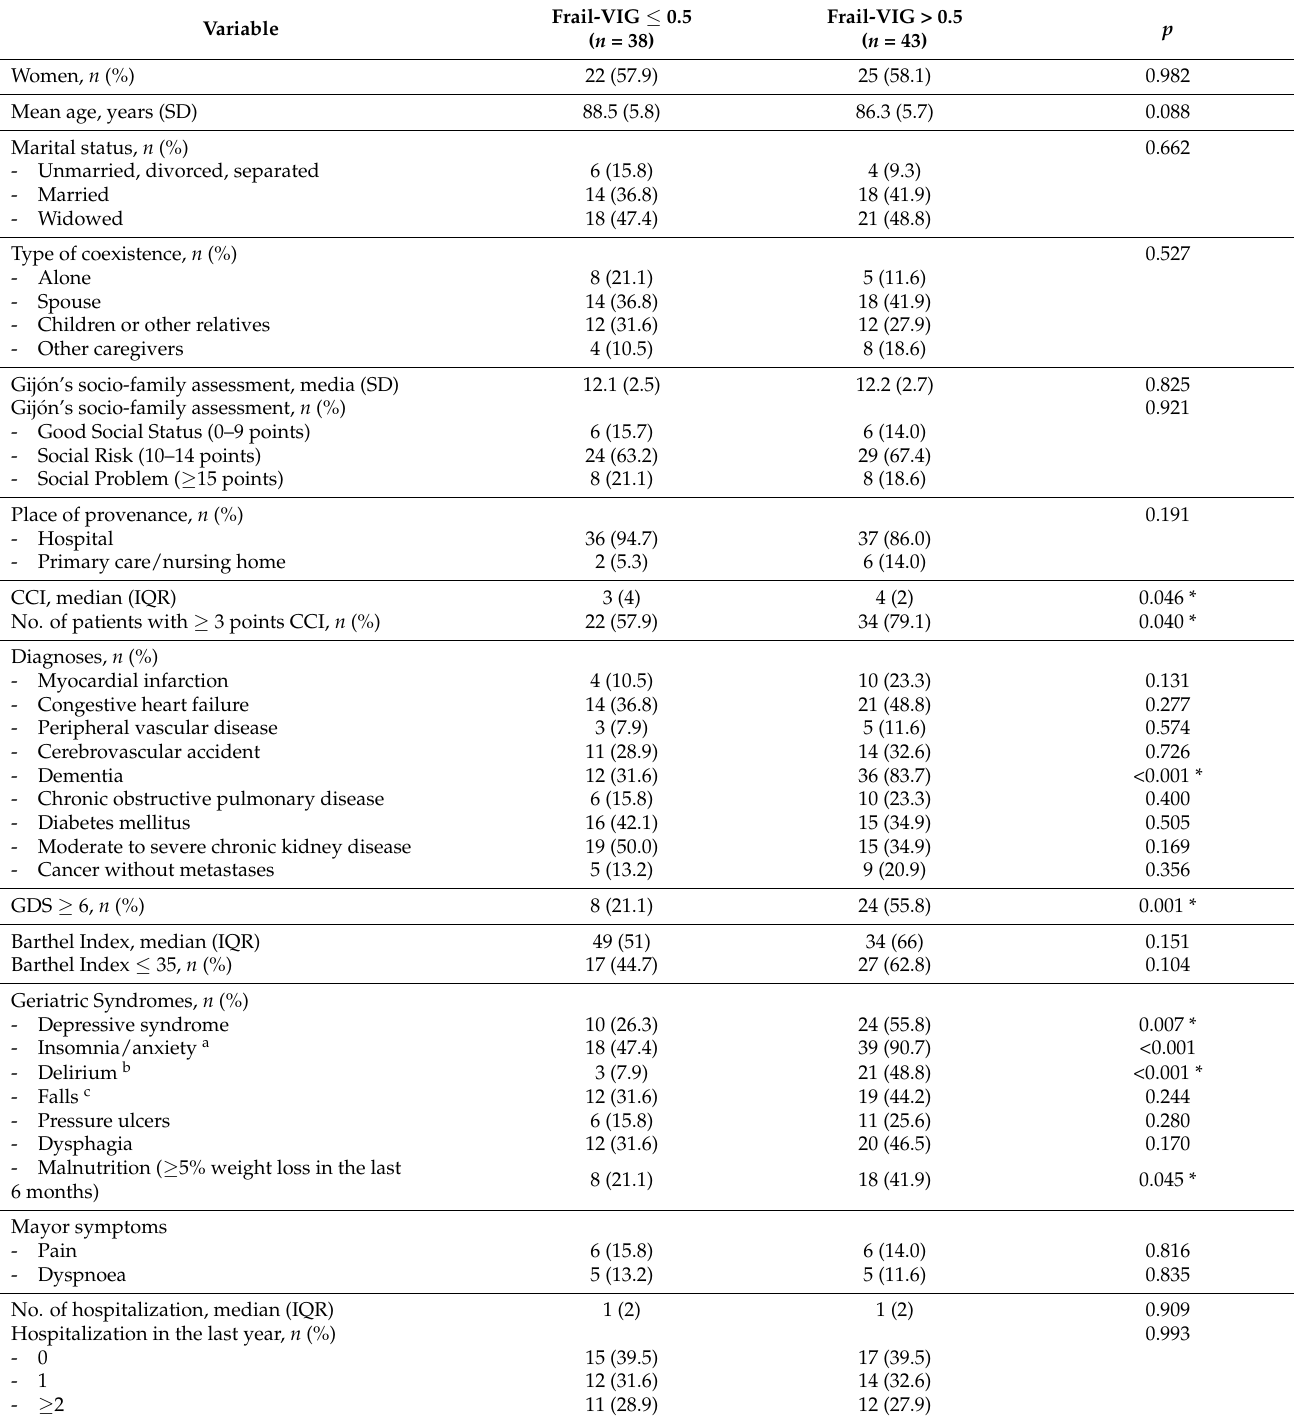
Table 2. Cohort baseline data according to frailty